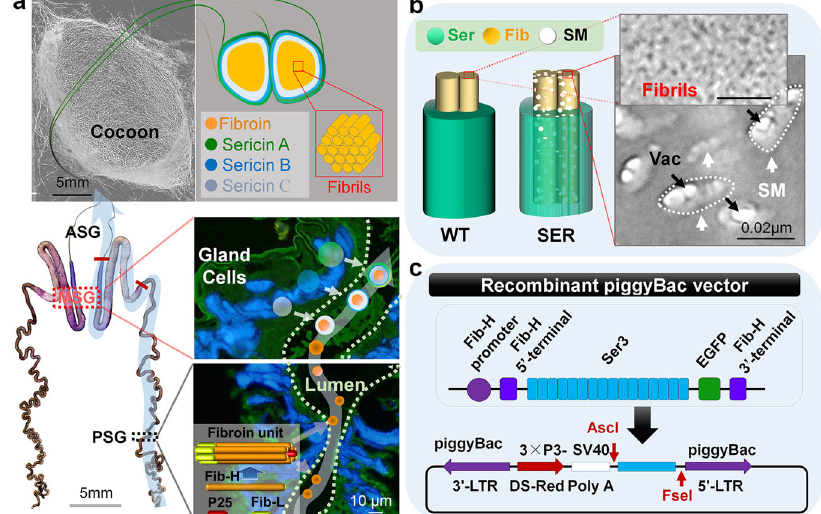
Fig. 1 | Construction of transgenic silkworms. a Schematic diagram of SGs pro- ducing cocoon silk. The silk fi brils are long chains formed by Fib-H/Fib-L/P25 polymer fi broin units synthesized by the PSG. The silk fi broin heavy chain protein (Fib-H), silk fi broin light chain protein (Fib-L), and P25 protein synthesized by PSG cells are secreted into the lumen as fi broin units and then are transferred to the MSG as a metastable high-concentration aqueous colloid. In the MSG lumen, the aqueous colloid of silk fi broin is surrounded by sericin C (sericin 1 is the main composition), which is secreted by the back end and middle part of the MSG, and then is surrounded by sericin B (mixed sericin) and sericin A (sericin 3 is the main composition), which are secreted by the middle and anterior part of the MSG. b Technical strategy. Ef fi cient transgenic expression of SER3 recombinant